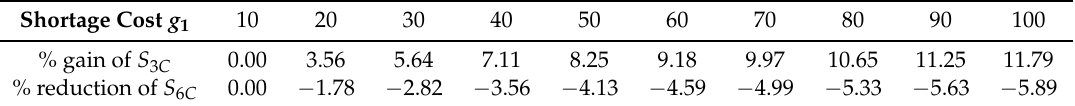
Table 3. Effect of g 1 on relative gain of S 3 C and relative reduction of S 6 C .